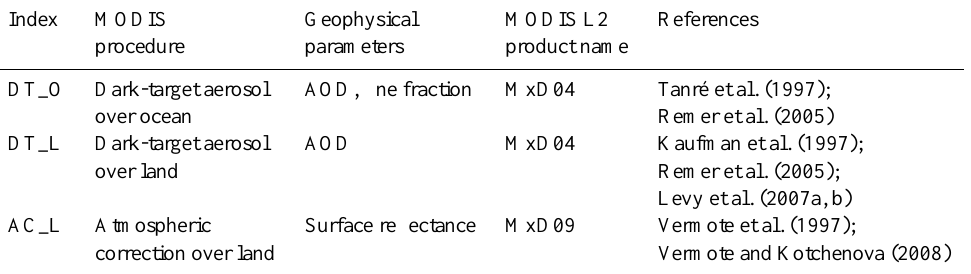
Table 1. Three MODIS products and their